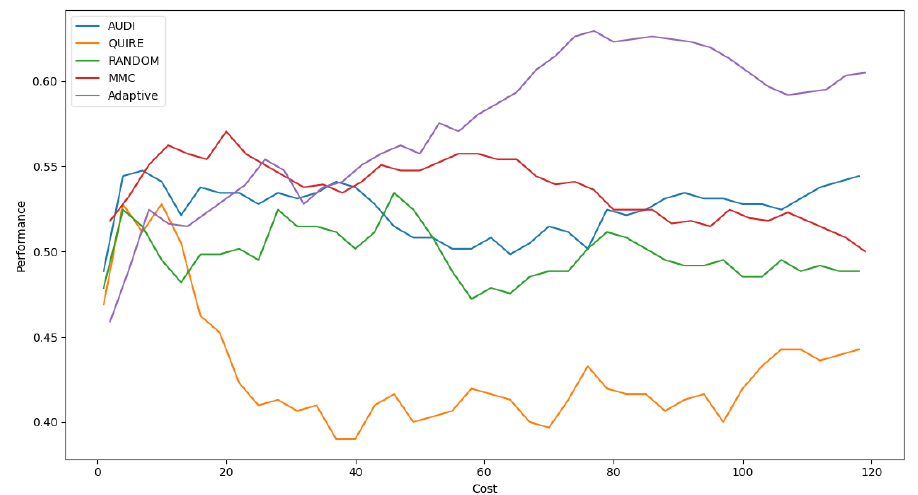
Figure 5. Classification accuracy for the five selection AL strategies without grid search optimizer.